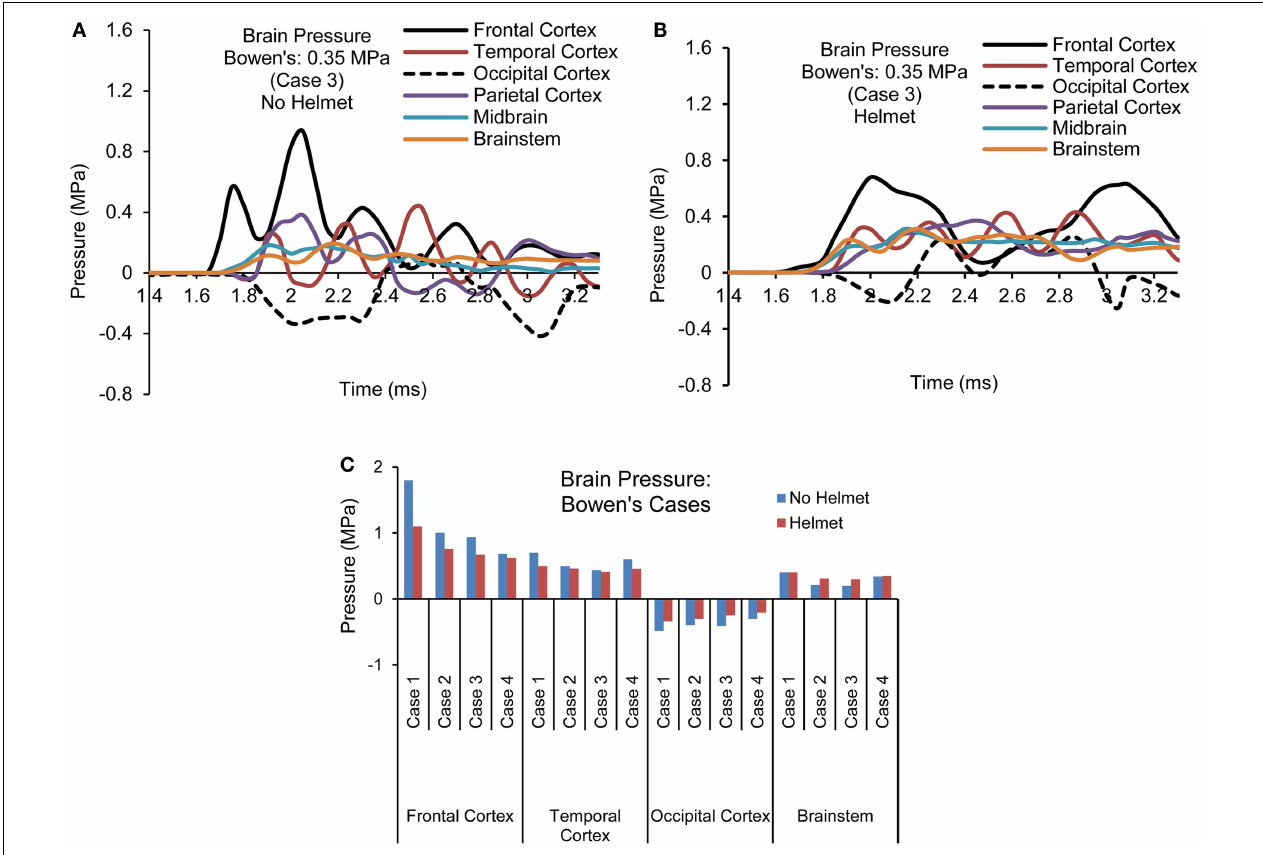
FIGURE 7 | Pressure time histories predicted in the brain of various regions (Case 3) (A) No helmet (B) Helmet, and (C) Comparison of peak pressure for all four cases based on Bowen’s curves .